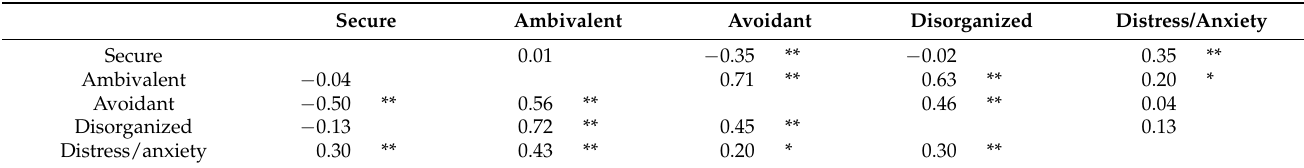
Table 7. Correlations between the ASCT-LPN scales for Clinical and Nonclinical